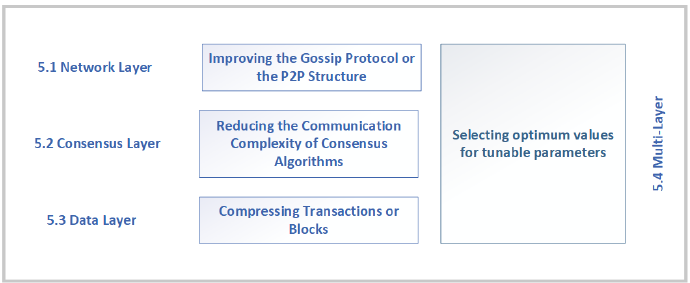
Figure 5. Categorization of Network Optimization Frameworks in Blockchain.